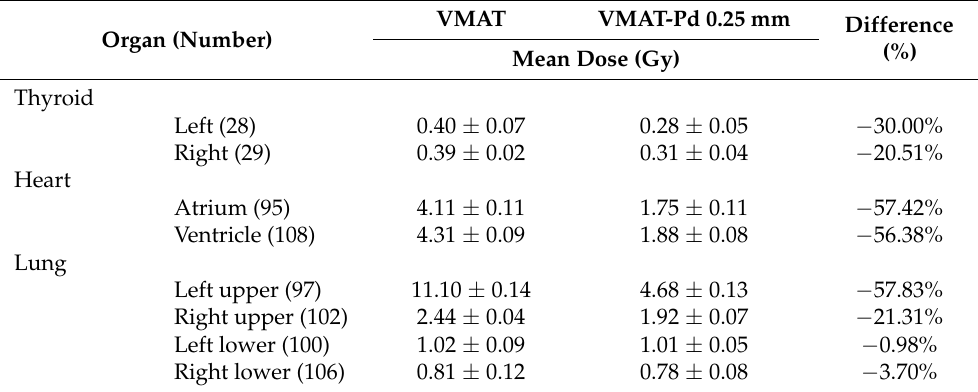
Table 7. Comparison of the OAR doses of the VMAT plan before and after the lead shield of thickness 0.25 mm was applied to the surface of the